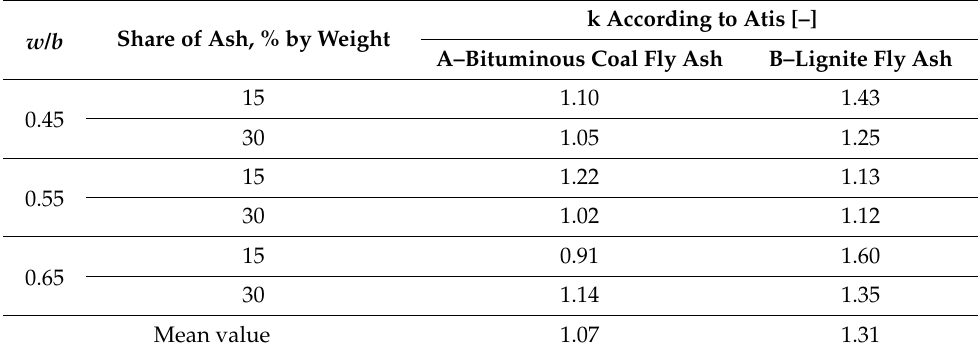
Table 10. Magnitudes of k-factors for fluidized bed combustion fly ashes A and B based on compres- sive strength test results after 28 days of concrete